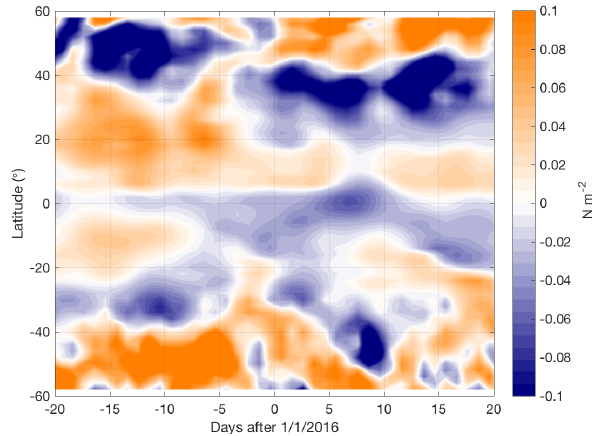
Figure 5. Time–latitude (Hovmöller) diagram of the zonal friction drag anomaly between 11 December 2015 and 20 January 2016 and averaged over longitudes between 180 and 270 ◦